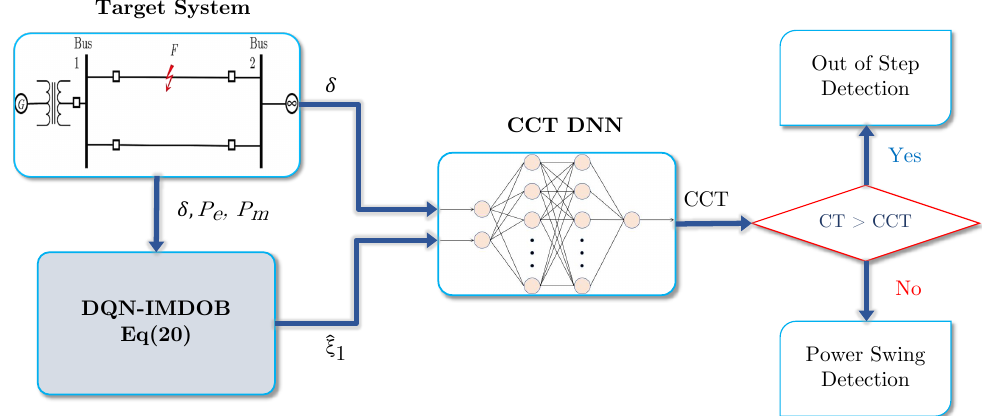
Figure 5. Proposed OOS prediction